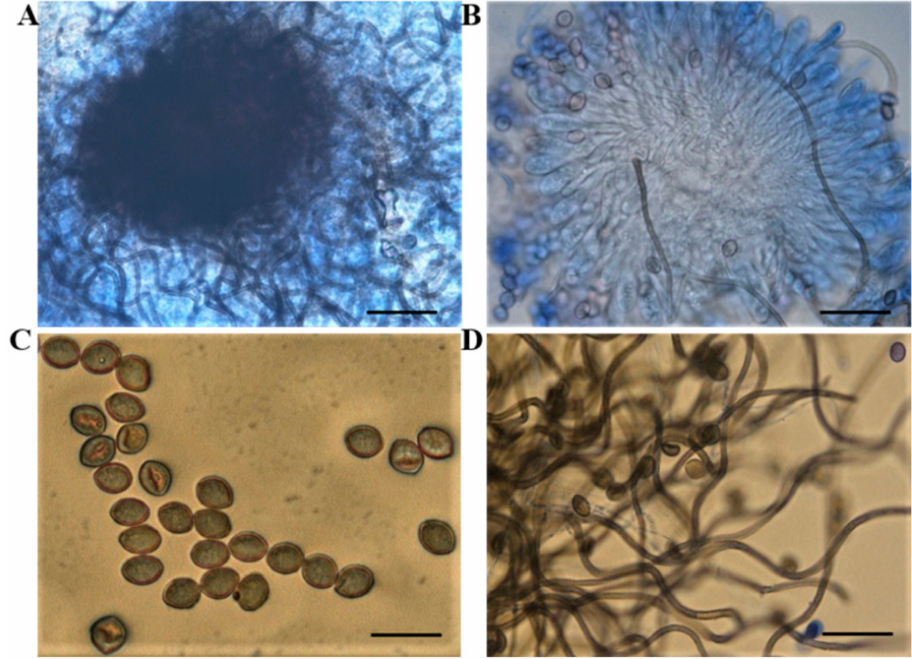
Figure 2. Microscopic observation of endophyte F5 under light microscope. ( A ) perithecium; ( B ) as- cus; ( C ) ascospores, and ( D ) appendage. Bars: A = 80 µ m, B = 60 µ m, C = 20 µ m, and D = 40 µ